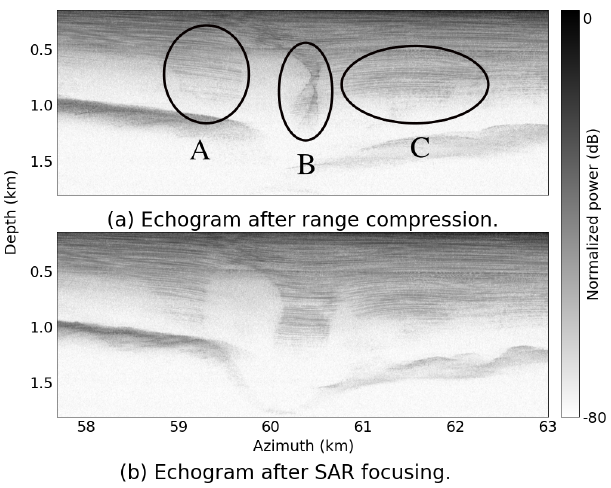
Figure 14. Stretching and shrinkage of internal layers in range- compressed data of track 2. The range-compressed echogram is shown in (a) , the SAR-focused echogram is shown in (b)